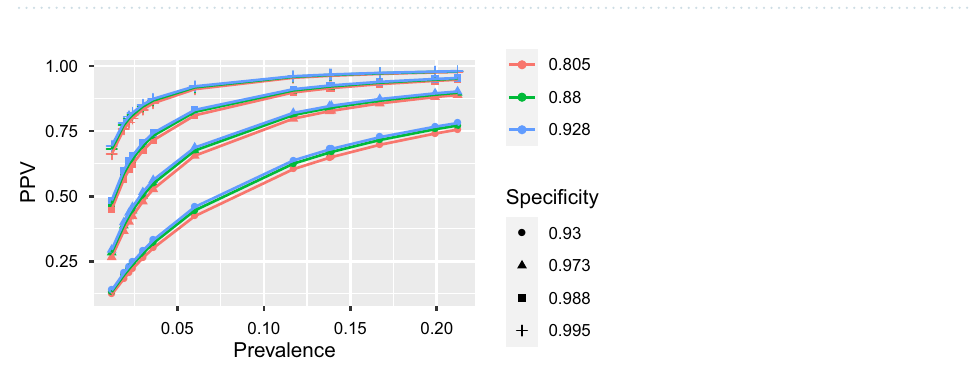
Figure 5. PPV for Antibodies test in Santa Clara County Study 37 . To reflect variation within and between references 37–39 , prevalence values are included from 0% to 5% by 0.2%.